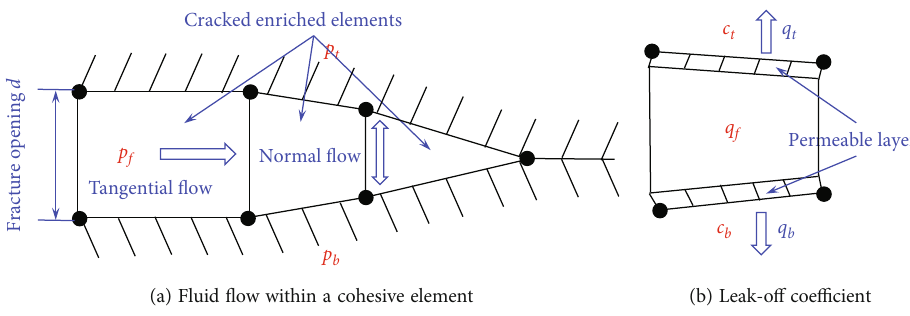
Figure 2: Fluid fl ow and leak-o ff within a cohesive